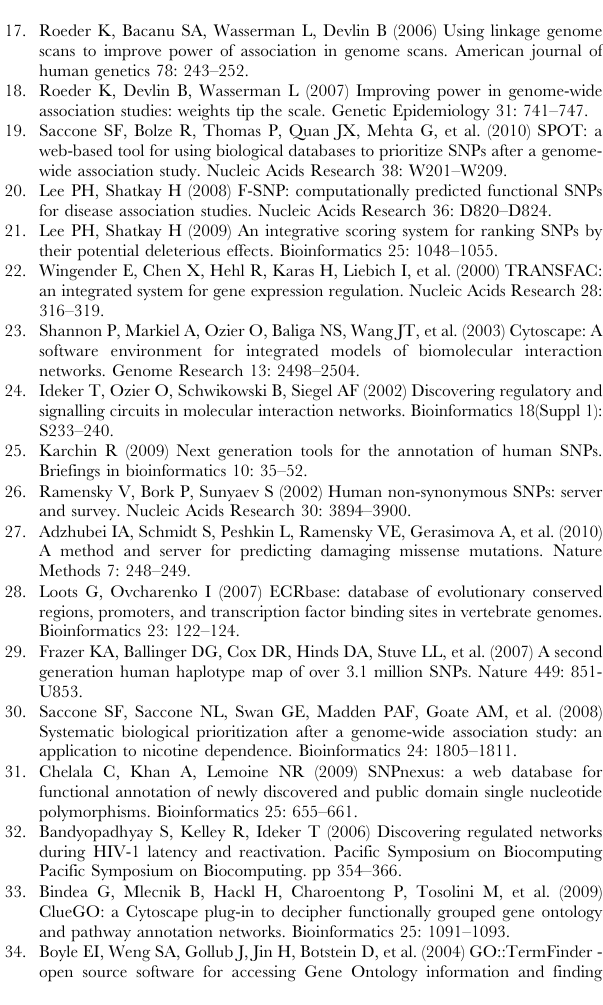
Table S1 Complete list of drug target genes for RA, downloaded from Pharmaccogenomics Knowledge Base website is shown in Table S1. Table S2 Complete list of the KEGG functional enrichment of drug target genes for RA is shown in Table S2. Table S3 List of 25 drug target genes that are found to be associated with RA when all the genes in the identified KEGG pathways are considered. Table S4 KEGG functional enrichment results for 100 ran- domly generated sub-networks is shown in Table